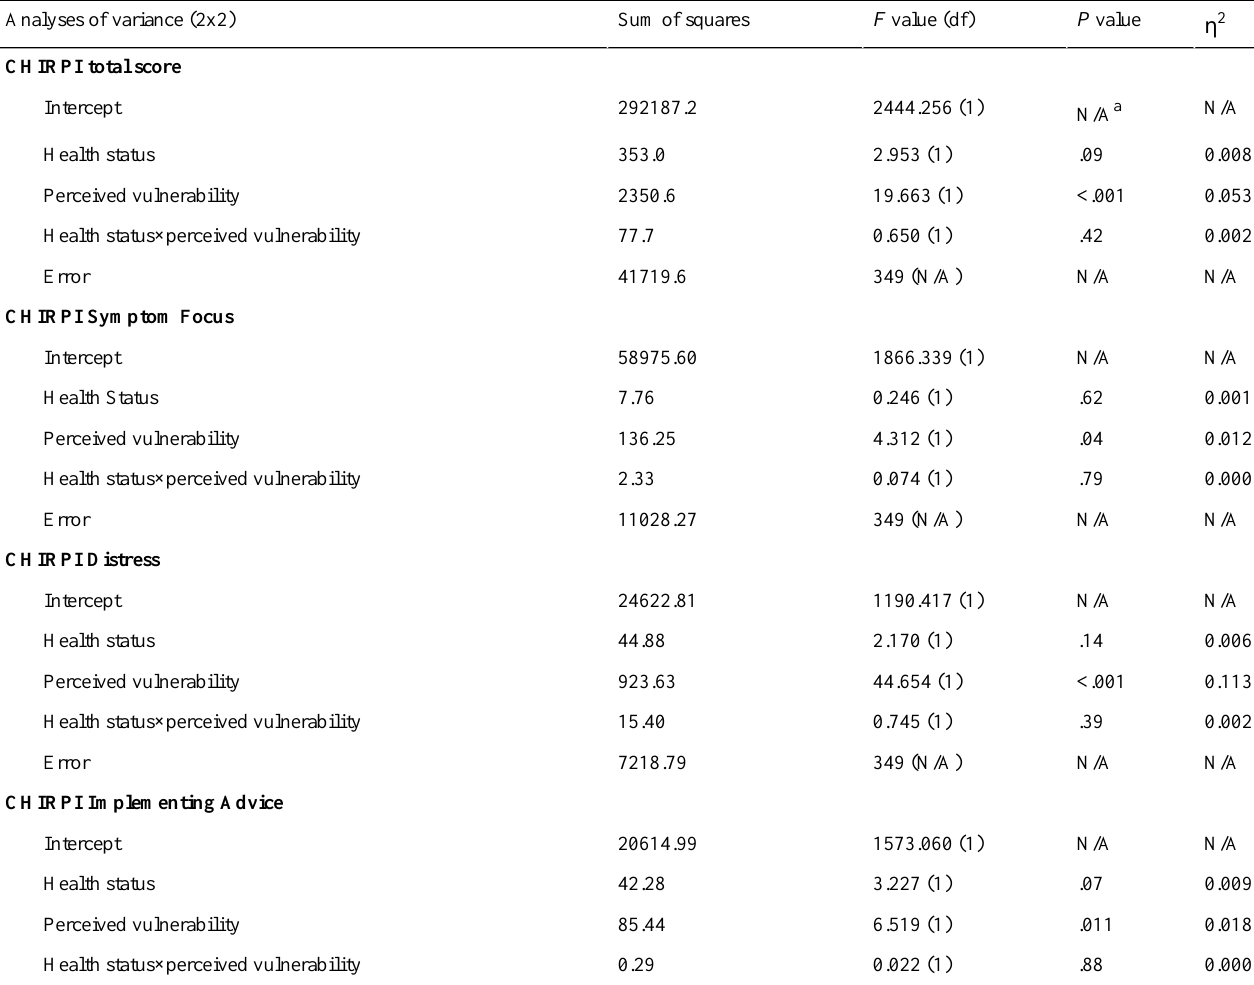
Table 7. Results of the 2×2 analyses of variance with the factors child’s health status and perceived vulnerability of the child and the dependent variables, Children’s Health Internet Research, Parental Inventory (CHIRPI) total score, and its